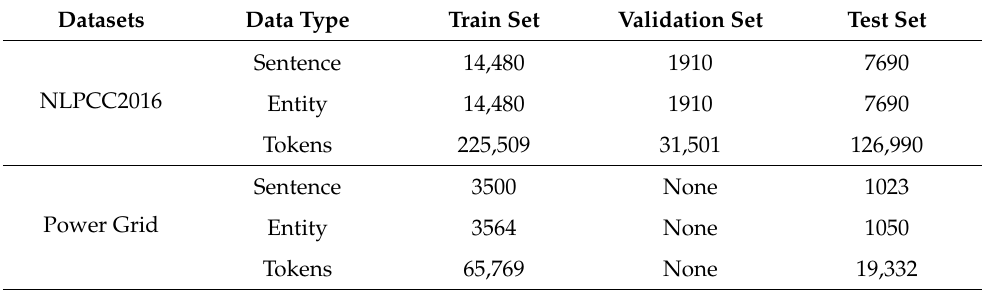
Table 3. Statistics of two datasets. Due to the relatively small size of the power grid data, we do not make a validation set for it.